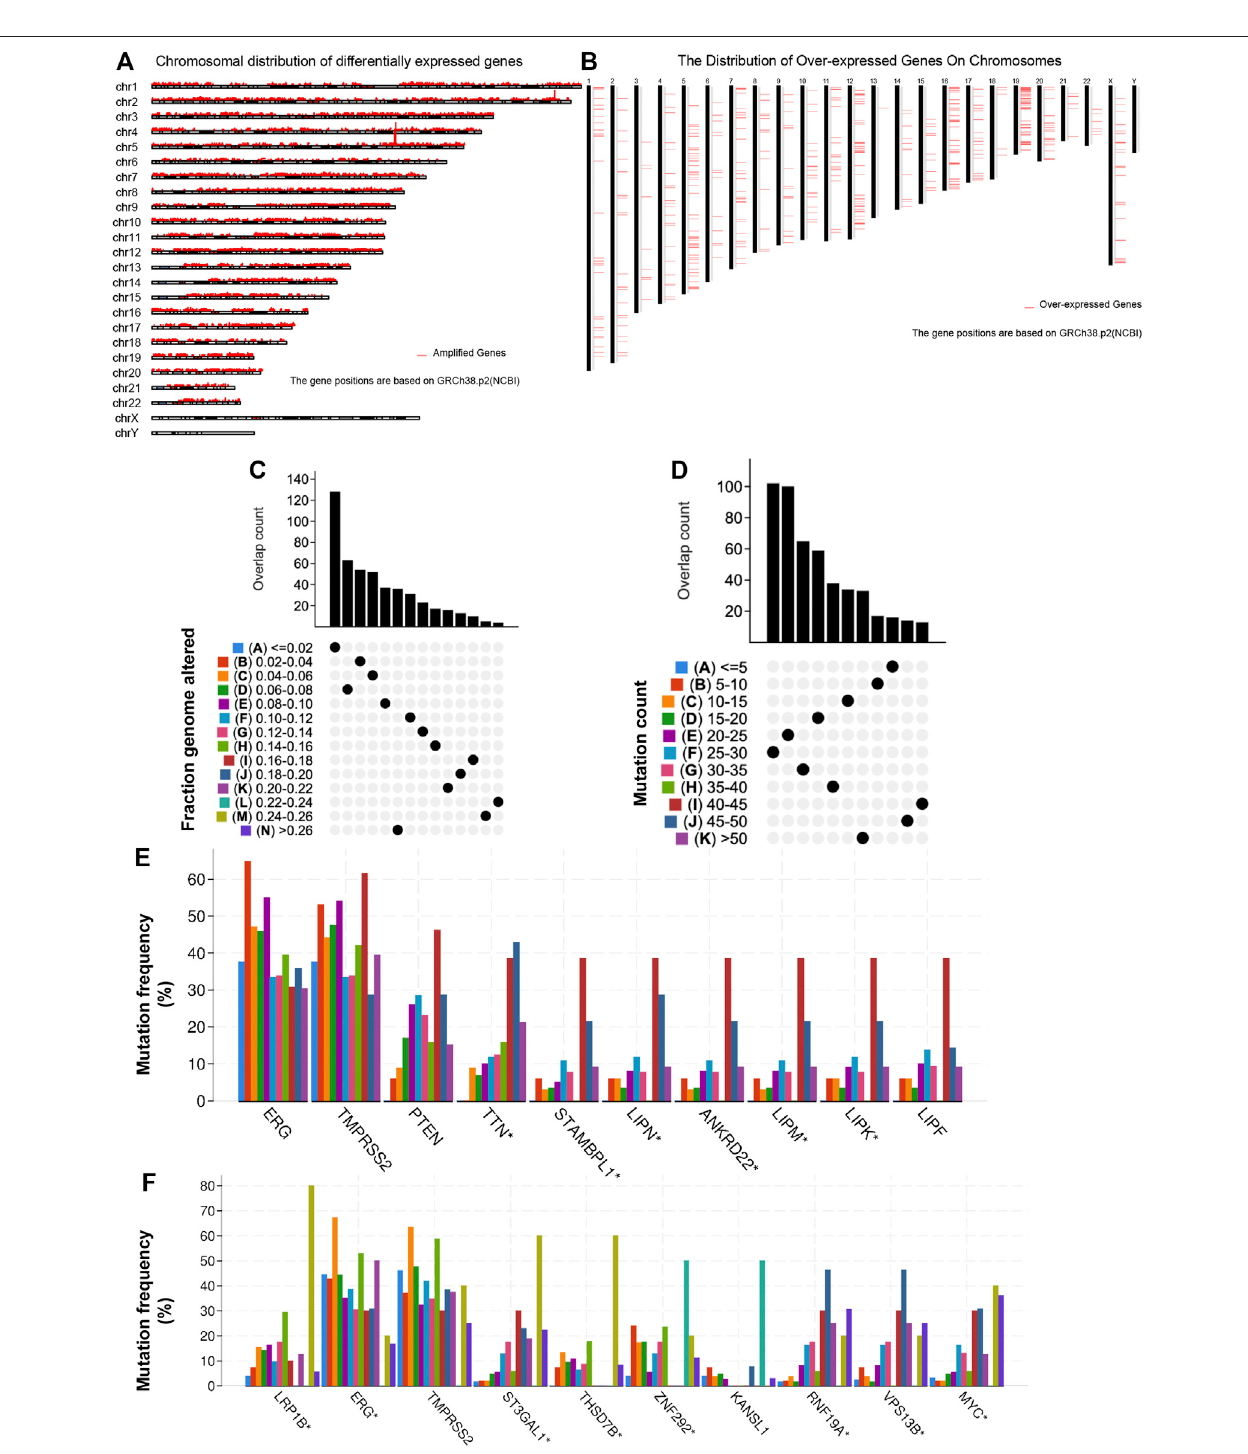
FIGURE 1 | Identi fi cation of potential tumor antigens in PRAD. (A) The chromosomal distribution of the aberrant copy number genes in PRAD is shown. (B) The chromosomal distribution of over-expressed genes in PRAD is shown. (C – F) Identi fi cation of potential tumor-speci fi c antigens in PRAD. Overlapping mutated genes distributed in the fraction genome altered group (C) and mutation count group (D) are shown. Genes with the highest frequency in the mutation count groups (E) and fraction genome altered groups (F) are individually shown.